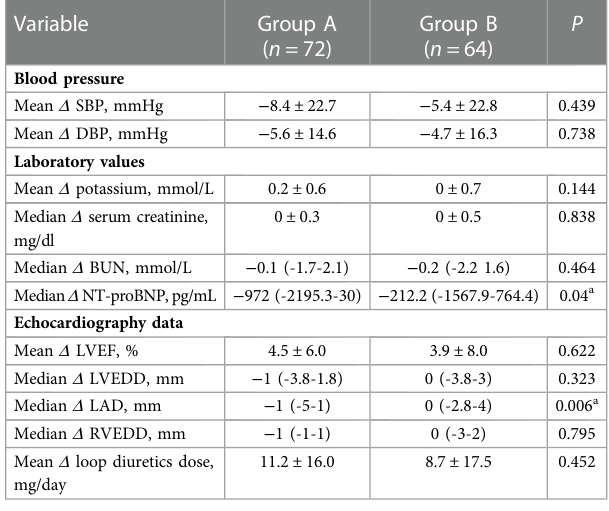
TABLE 2 Comparisons of changes in clinical parameters from baseline to follow-up between group A and group B.